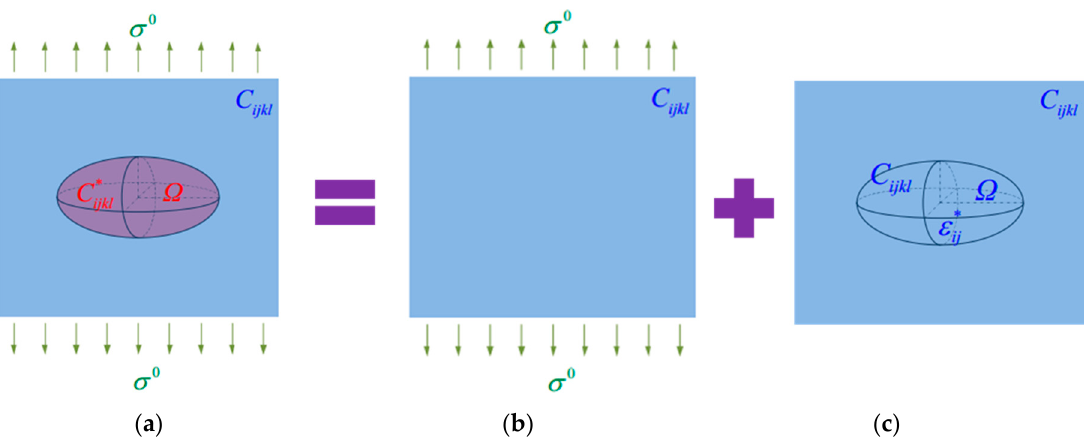
Figure 4. ( a ) The disturbance of an inhomogeneity to the matrix can be substituted by the superposition of ( b ) a homogeneous solution without inhomogeneity and ( c ) an equivalent inclusion solution with properly assigned eigenstrains.